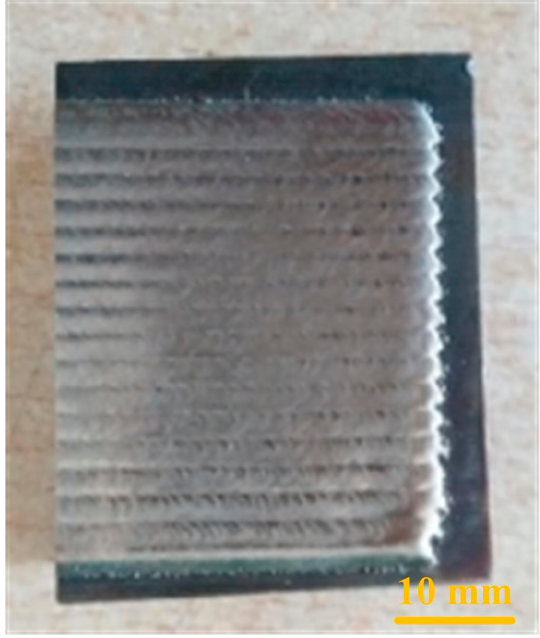
Figure 4. Macromophology of the